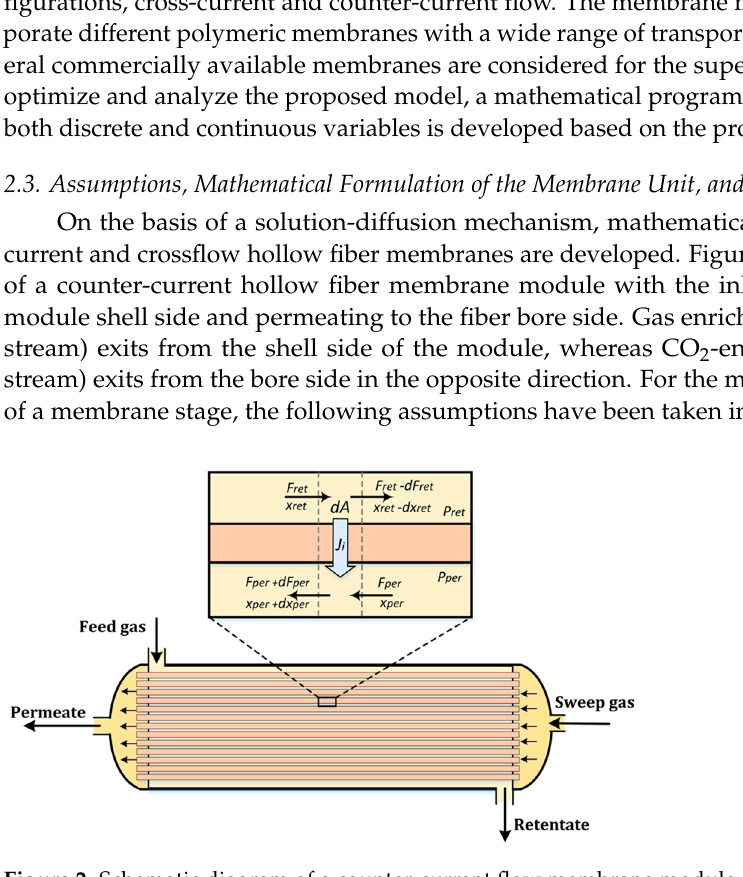
Table 2. Mathematical equations for modeling membrane stage .